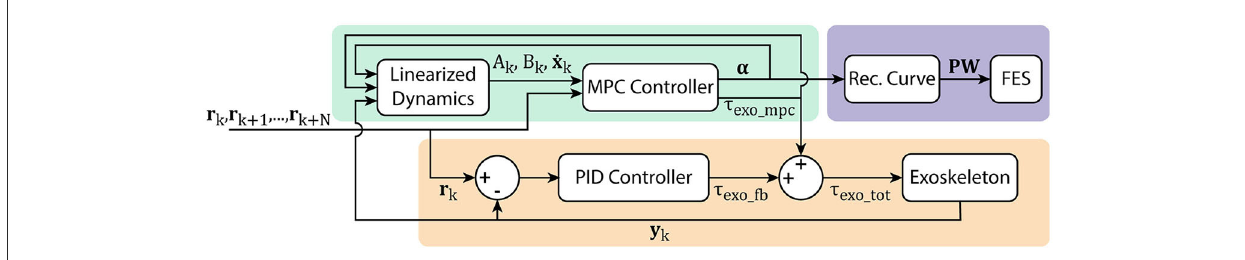
FIGURE5 Hybrid FES-exoskeleton control block diagram, showing how the different components of the hybrid controller work together to provide torque commands to the robot and pulse width commands to the stimulator given a desired input